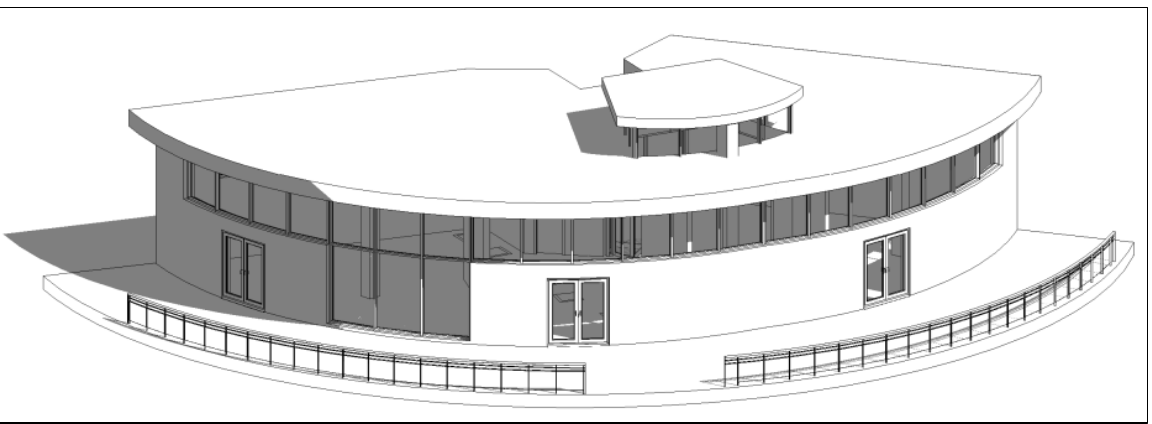
Figure 39. Visitors Centre. It can clearly be seen that the visitors centre is practically made of 2 or more houses merged in one larger building. Lepenski Vir, Serbia (2019) by ArhiArhi (Predrag, Vladimir and Grigor Milošević) Thus, the ability to place the green roof on the buildings is open, as they are quite simple both in appearance and construction. The green roof would have kept moisture, evaporation, and cooled longer than a regular roof. Also, since the roof is at a height of only 1.5 meters, it can also be used as a green surface. On that surface, one could sit and enjoy the view. It is possible that there was a green roof on old Lepenski Vir houses. It is known that sods of moss or grass were used as a blanket in the construction of houses, and this could be the case in Lepenski Vir (Figures 40 to